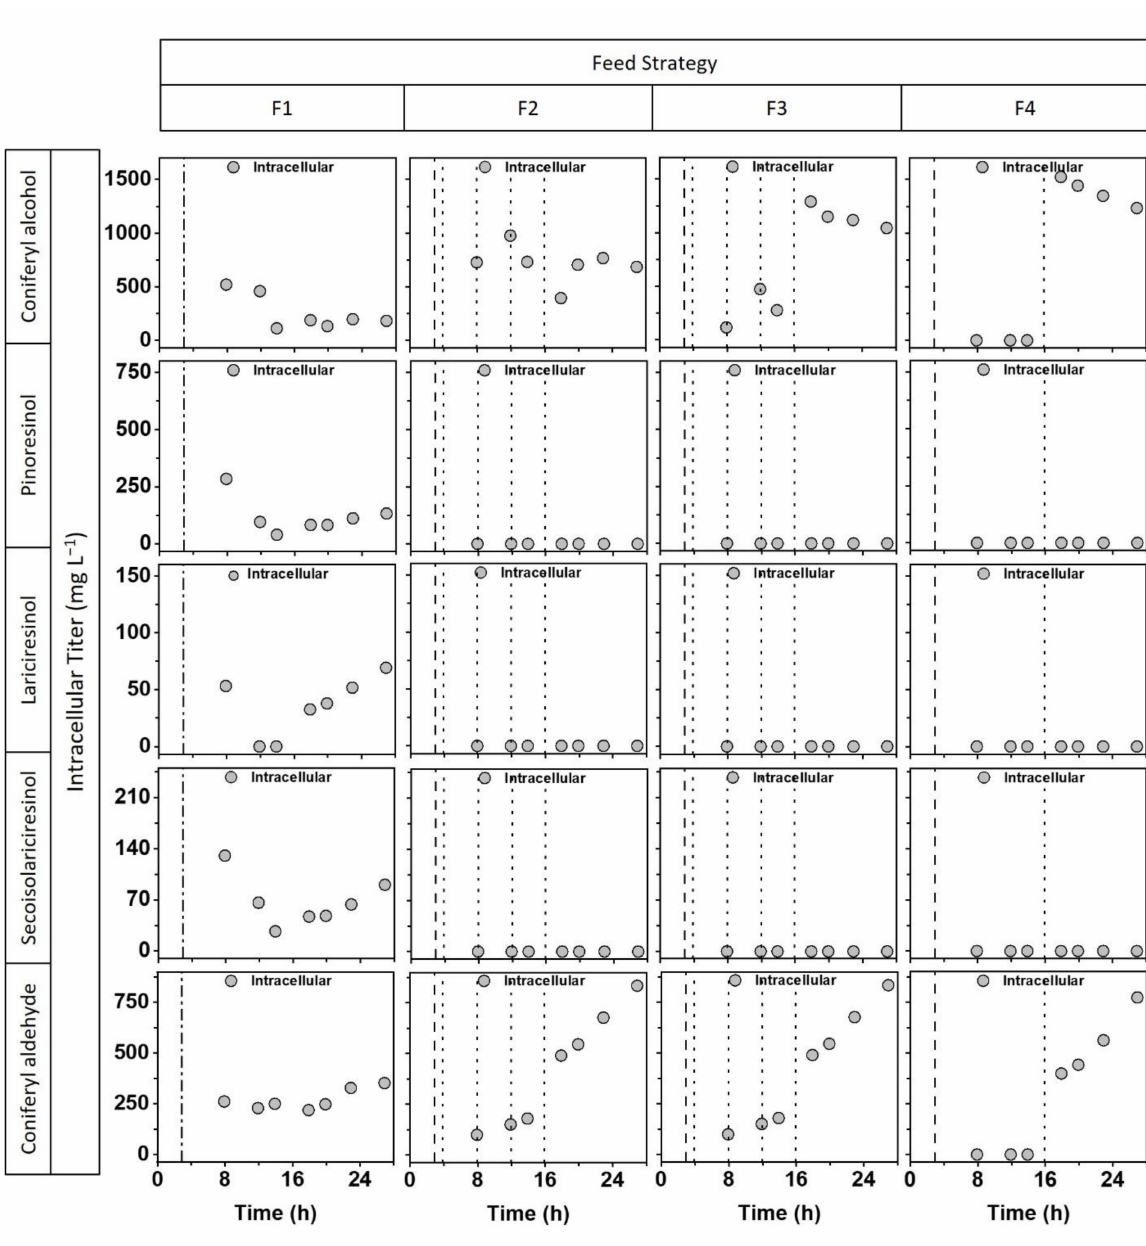
Figure 5. Comparison of substrate-feeding strategies during STR cultivation. E. coli C43(DE3) pCDF- Duet_syfiPLR was cultivated at 37 ◦ C, 1000 rpm, in modified Riesenberg medium with 0.01% ( v / v ) AF204. At OD 600 0.6, 0.75 mM IPTG and 50 µ M CuSO 4 were added (pointed-dashed or dashed lines). After induction, the cultivation temperature was reduced to 30 ◦ C. For F1, 0.5 g L − 1 coniferyl alcohol was added at the time of induction (pointed-dashed line). Regarding F2 and F3, the amount of substrate corresponding to a final concentration of 0.5 g L − 1 coniferyl alcohol was split and sup- plemented at 1, 5, 9, and 13 h after induction (pointed lines). For F2, substrate was added in a linear pulsed feed of 25% (corresponding to 125 mg L − 1 ) or for F3 in an exponential pulsed-feed profile with 1.25% (6.25 mg L − 1 ), 5% (25 mg L − 1 ), 18.75% (93.75 mg L − 1 ), and 75% (375 mg L − 1 ). For F4, 0.5 g L − 1 coniferyl alcohol was added at 13 h after induction (pointed line). Cultivations were ended 24 h after